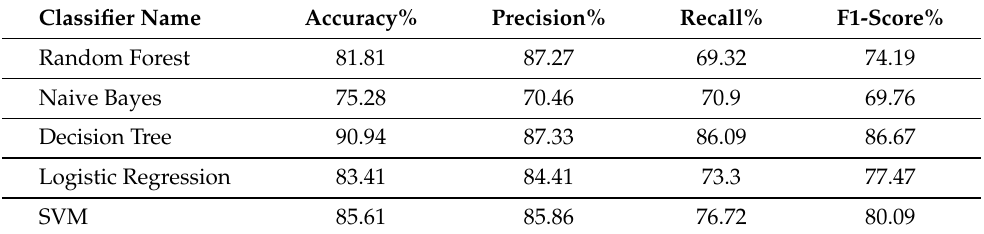
Table 4. Machine learning performance on AstraZeneca dataset.